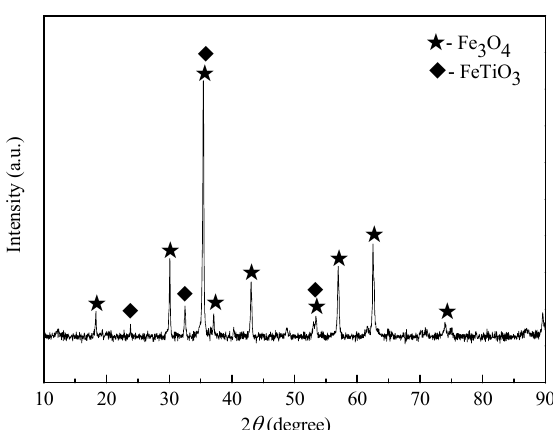
Figure 2. XRD pattern of vanadium-bearing titanomagnetite concentrate used in this study.